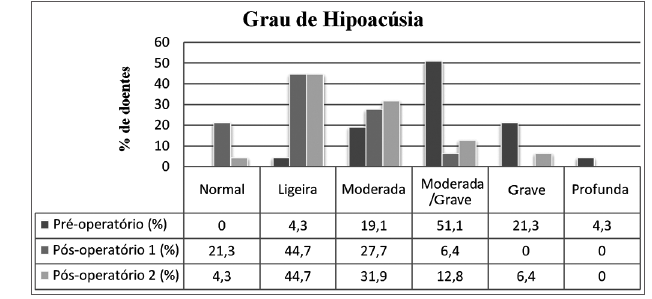
Figura 5. Grau de hipoacusia pré-operatória e pós-operatória imediata (1) e tardia (2).